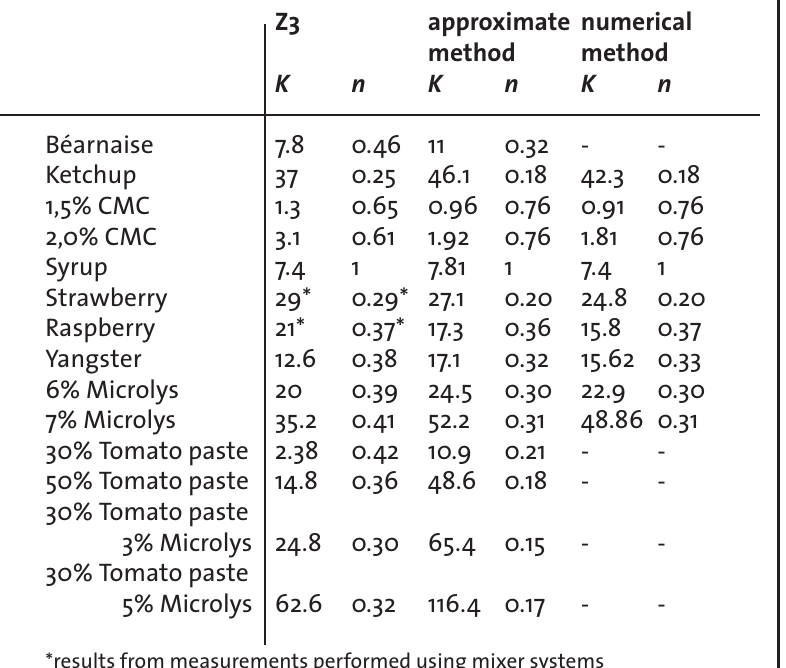
*results from measurements performed using mixer systems Figure 8 (right): Shear stress versus shear rate calculated using obtained constants and the method based on the Cou- ette analogy. Results obtained with small paddle for 30% tomato paste con- taining 5% Microlys. Table 2: Results from DCC using con- ventional method (Z3), approximate method (Eq. 7), and numerical